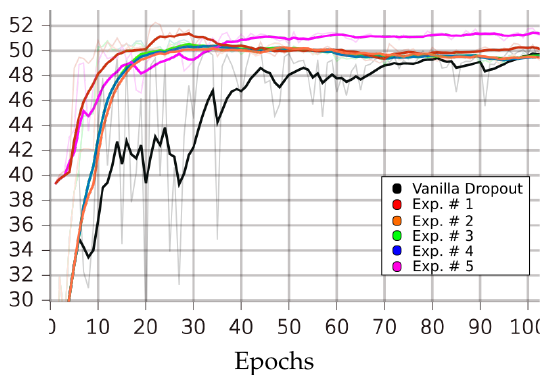
Figure 7. Performances of LIM and vanilla dropout methods on the STL-10 dataset, trained and tested for 100 epochs. Graphs were smoothed for better comprehension; original graphs can be seen in the background. Curves correspond to Table 4 scores; black: vanilla, red: 1, purple: 2, green: 3, orange: 4, blue: